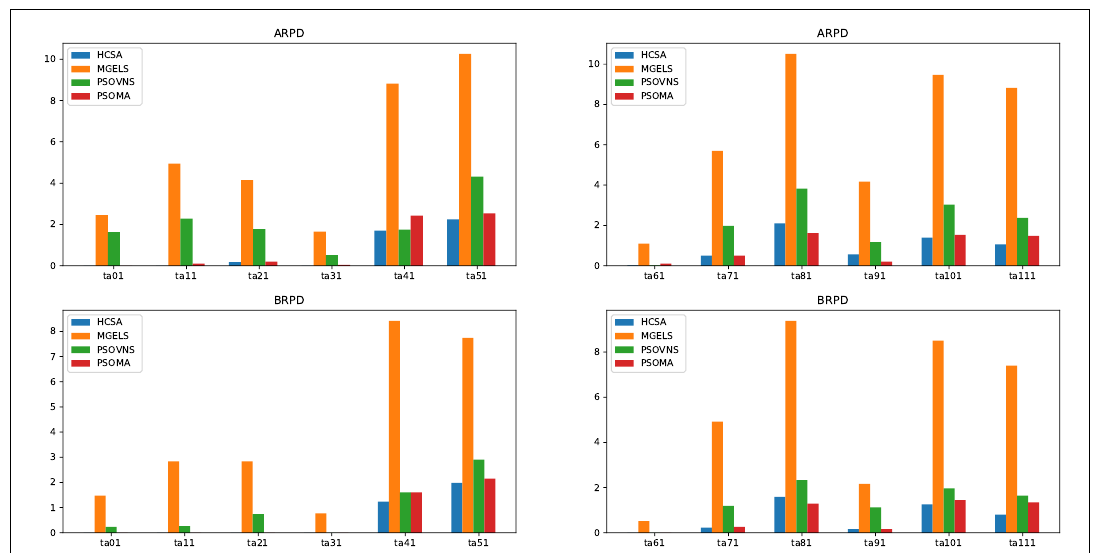
Figure 4. Comparison of the results for various metaheuristic